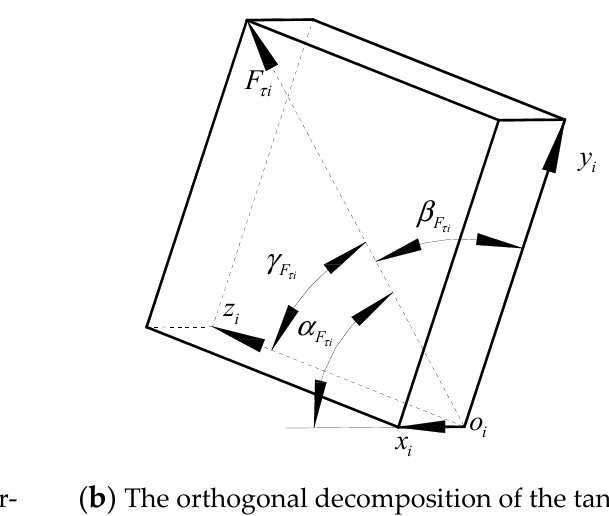
( a ) The orthogonal decomposition of the nor- ( b ) The orthogonal decomposition of the tangen- mal collision force tial collision force Figure 7. Schematic diagram of the orthogonal decomposition of the fruit harvesting collision force under the i-grade branch. Note: α F is the angle between the normal collision force F ni and the x i axis ni of the i-grade branching coordinate system x i y i z i (rad); β F is the angle between the normal collision ni force F ni and the y i axis of the i-grade branching coordinate system x i y i z i (rad); γ F is the angle ni between the normal collision force F ni and the z i axis of the i-grade branching coordinate system x i y i z i (rad); α F is the angle between the tangential collision force F ni and the x i axis of the i-grade τ i branching coordinate system x i y i z i (rad); β F is the angle between the tangential collision force F ni τ i and the y i axis of the i-grade branching coordinate system x i y i z i (rad); γ F is the angle between the τ i tangential collision force F ni and the z i axis of the i-grade branching coordinate system x i y i z i